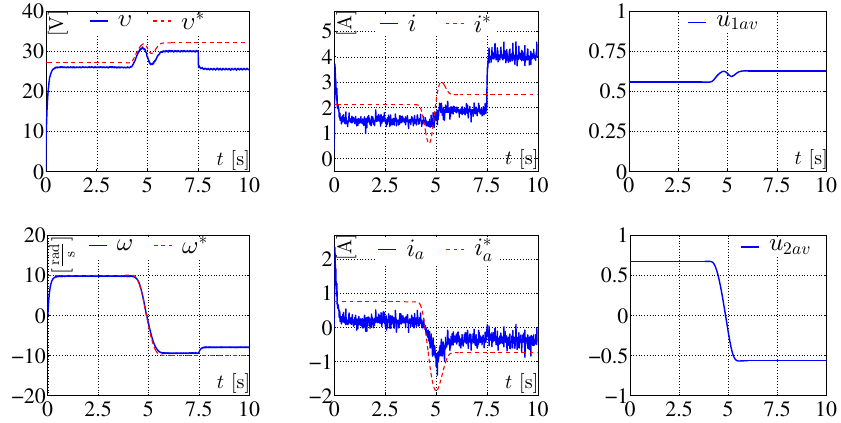
Figure 15. System response for Equations (32)–(33), parameters given by Equation (37), and abrupt variation in load R